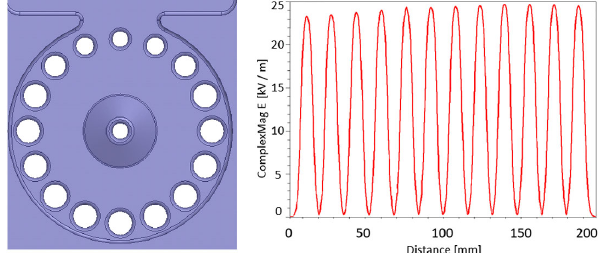
FIG. 2. Input coupling cell (left) and electric field profile in the structure (right). Note the variation in the coupling hole radii.